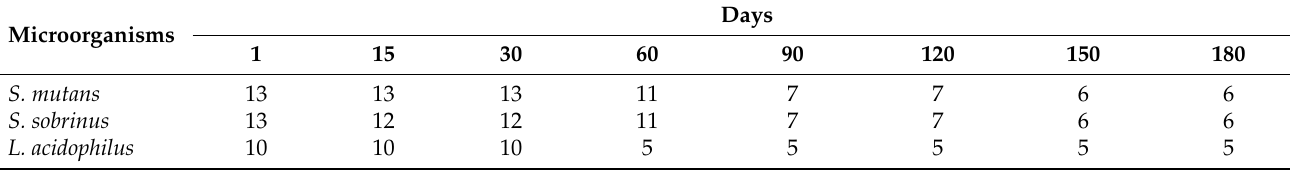
Table 8. Sizes of the inhibition zones of bacterial growth by orthodontic adhesives containing photoactivated 7.5 wt. % ZnO NPs/cCur,